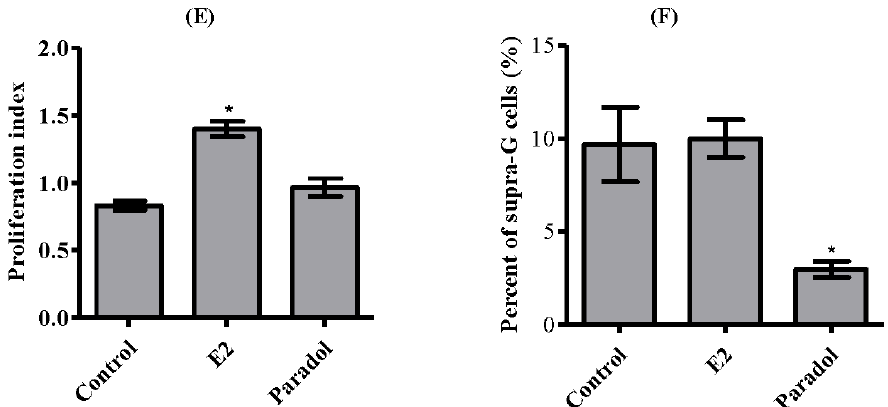
Figure 4. Effect of paradol on the cell cycle distribution of SAOS-2 cells. Cells were exposed to paradol (1 µ M) for 24 h ( B ) and compared to control untreated cells ( A ) and E 2 (0.1 µ M) treated cells ( C ); Cell cycle distribution was determined using DNA flow cytometric analysis, and different cell phases were plotted ( D ) as the percentage of total events. The proliferation index was calculated and plotted ( E ); Supra-G 2 /M cell population was plotted as the percent of total events ( F ). Data are presented as mean ± SD; n = 3. * Significantly different from control untreated cells; p < 0.05.